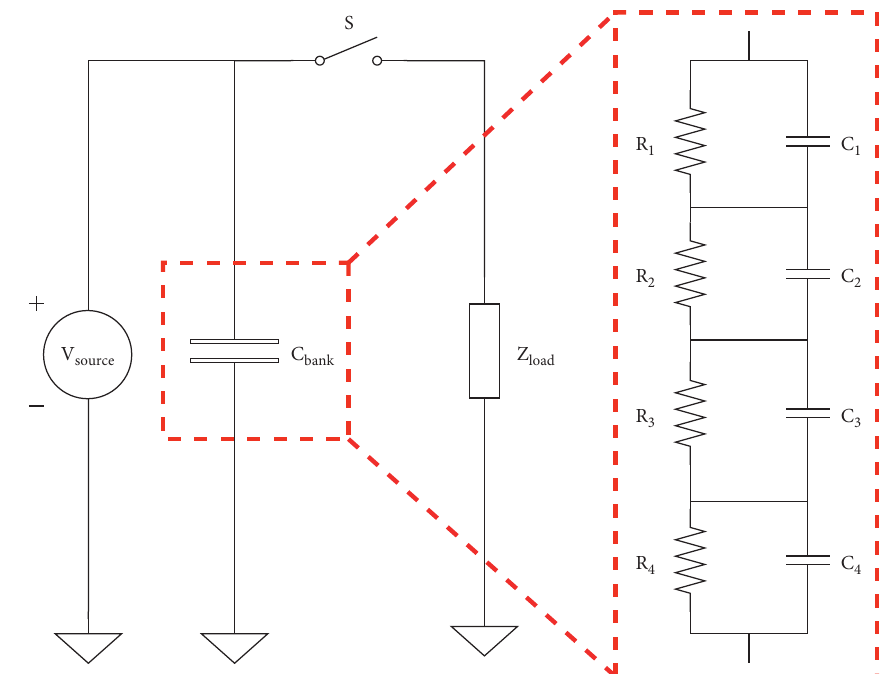
Figure 3: The implementation of the capacitor-discharge method to generate a square-wave pulse.